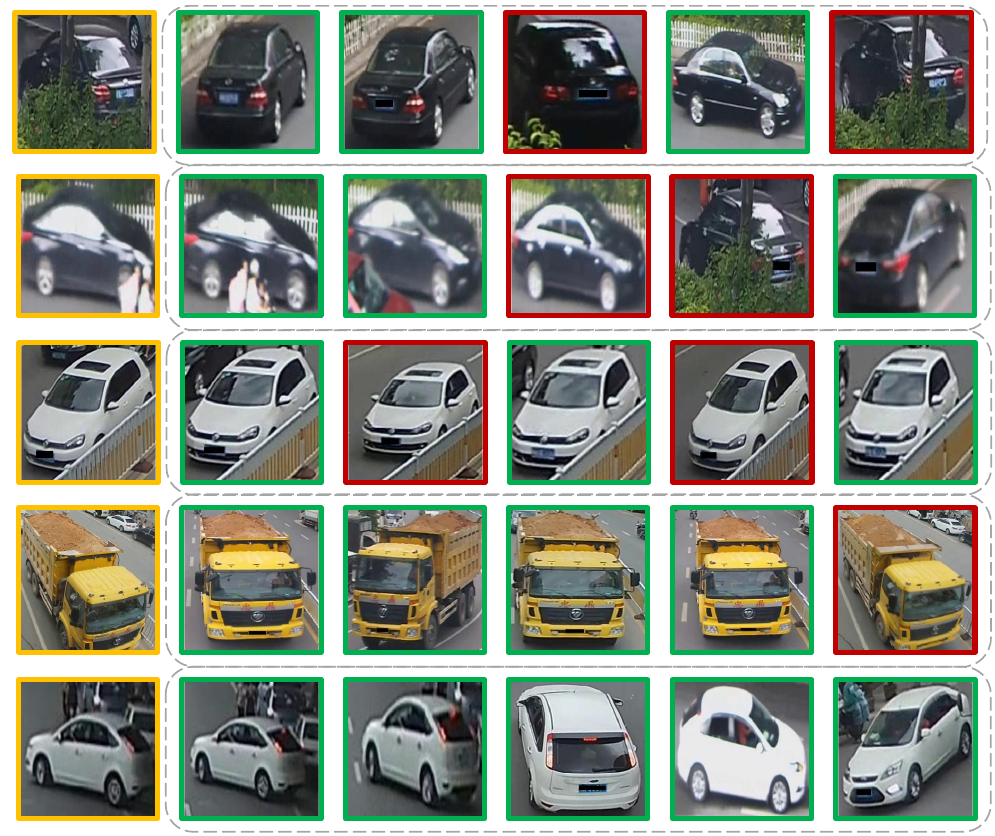
Figure 18. Visualization of five different predicted matches, shown in order from the top-10 ranking list. Given a query (yellow), the model either retrieves a match (in green) or a non-match